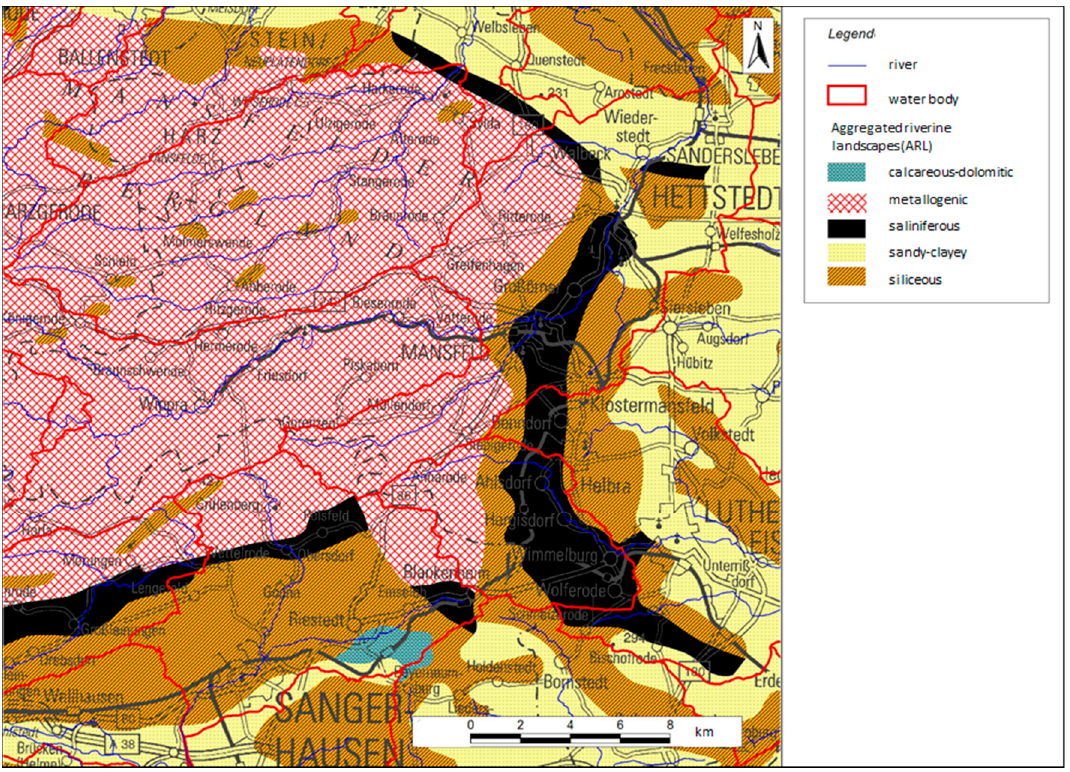
Figure 2. Aggregated riverine landscapes of the East Harz Mountains (metallogenic), and the Mansfeld copper shale area (saliniferous, siliceous).